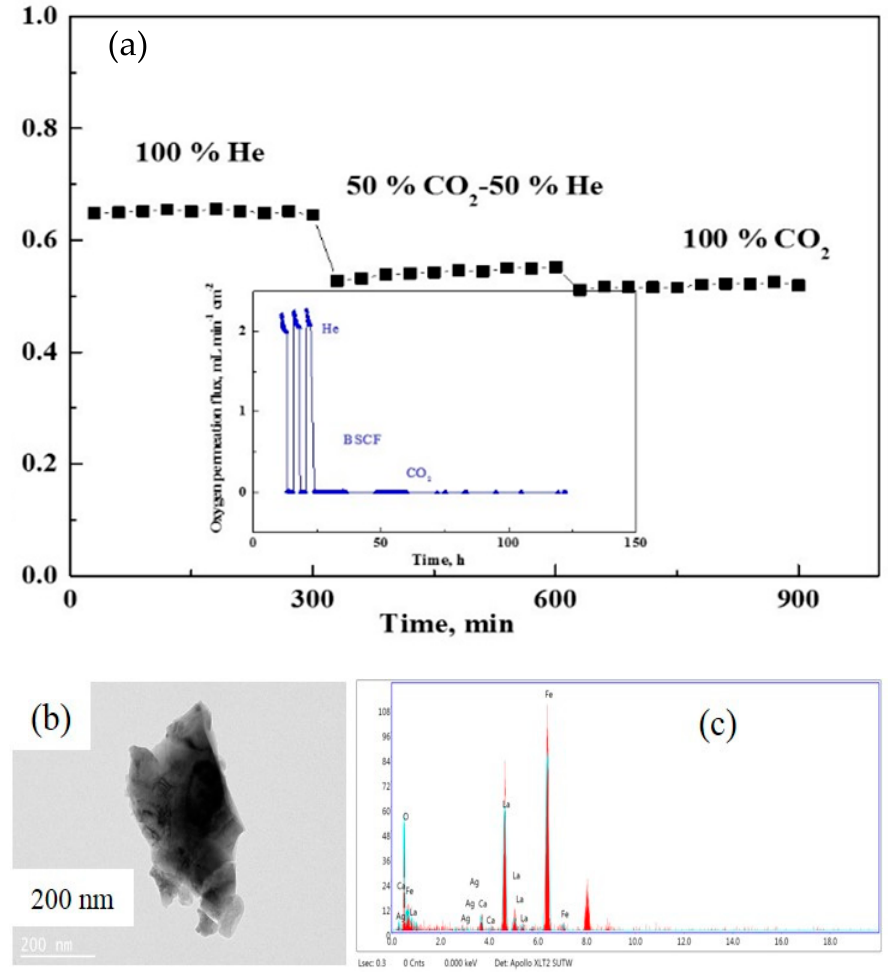
Figure 7. Oxygen permeation stability test ( a ) (flux versus permeation time) of LCFA hollow fiber membrane (operation temperature at 900 °C swept by 100% He, 50% He + 50% CO 2 , and 100% CO 2 for 900 min; sweep gas flow rate: 100 mL min − 1 ). (Inset: previous result of Ba 0.5 Sr 0.5 Co 0.8 Fe 0.2 O 3 − δ membrane swept by 100% He and 100% CO 2 [41]) and typical TEM ( b ) and EDS spectra ( c ) of the LCFA powder crushed from LCFA hollow fiber membrane after permeation test.